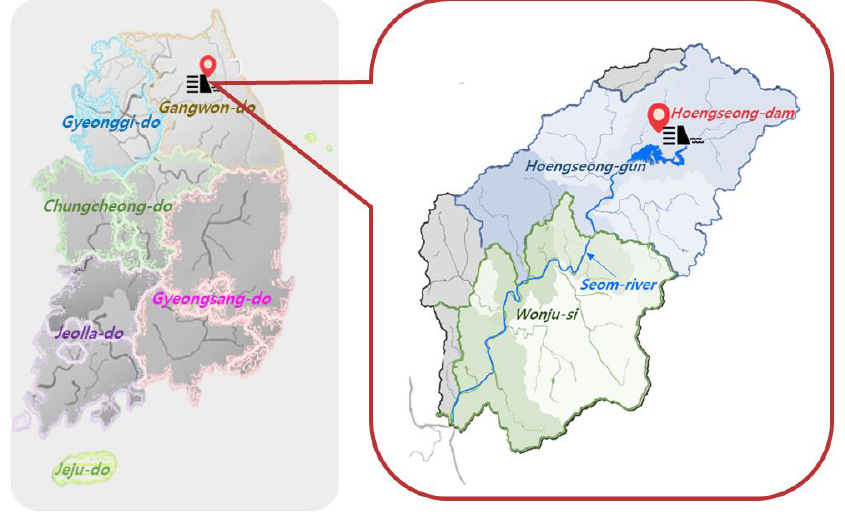
Figure 1. Location of the Hoengseong multi-purpose dam. Table 1. Specifications of the Hoengseong multi-purpose dam.